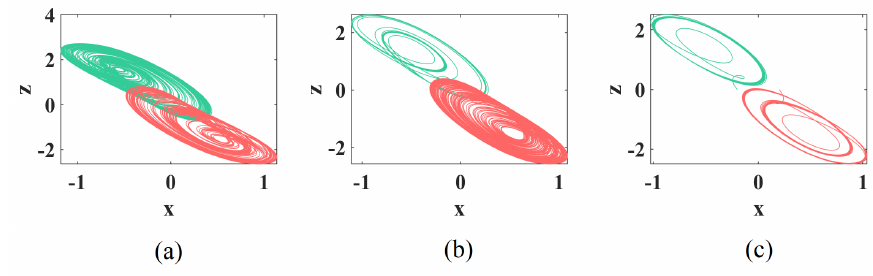
Figure 7. The coexistence of attractors in x-z plane. ( a ) k = 1.4, ( b ) k = 1.3, ( c ) k = 1.2.